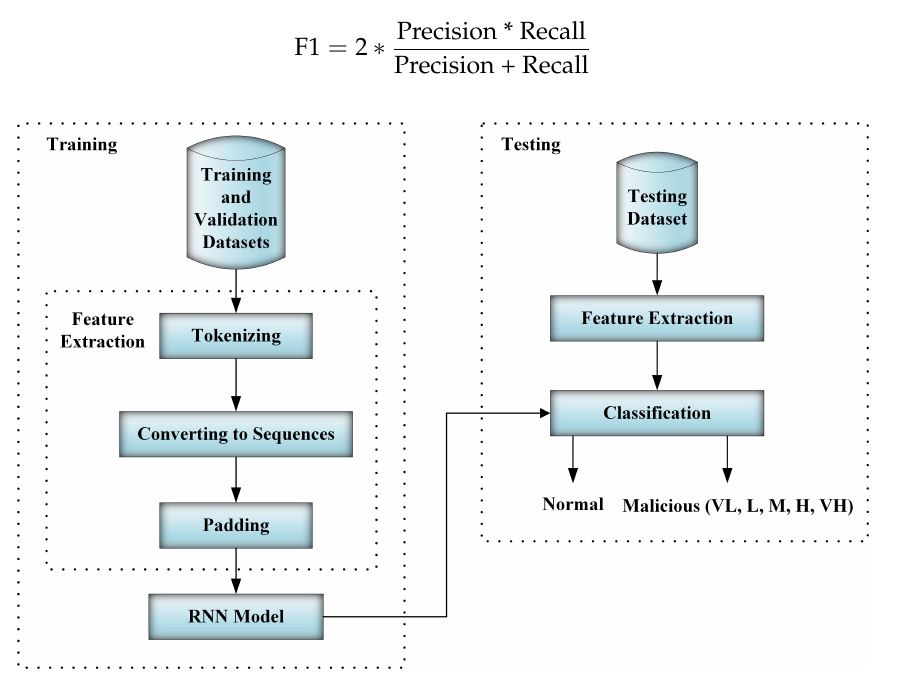
Figure 4. Training and testing